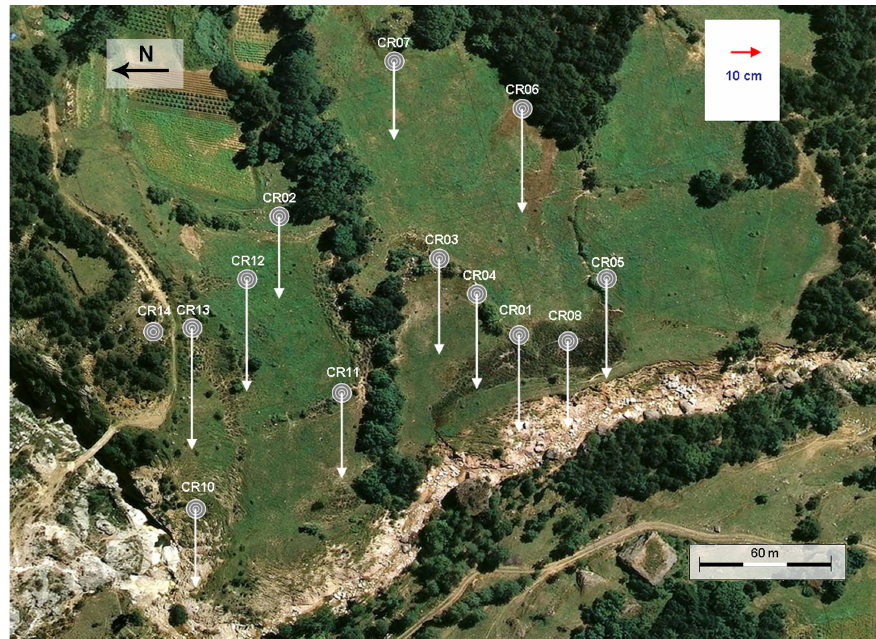
Fig. 6. Aerial photo of the measured area with the accumulated displacement vectors for those CRs with reliable results in the period February 2010 to September 2010. Note that only the magnitude is plotted. The maximum measured displacement in this period corresponds to CR13 with 39.8cm. The aerial photo is courtesy of the Cartographic Institute of Catalonia.